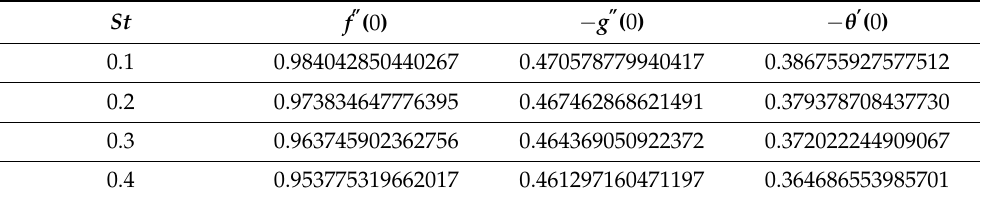
Table 2. Numerical results for f ” ( 0 ) , − g ” ( 0 ) and for − θ ’ ( 0 ) for various values of St = 0.1,0.2,0.3,0.4, while other parameters are